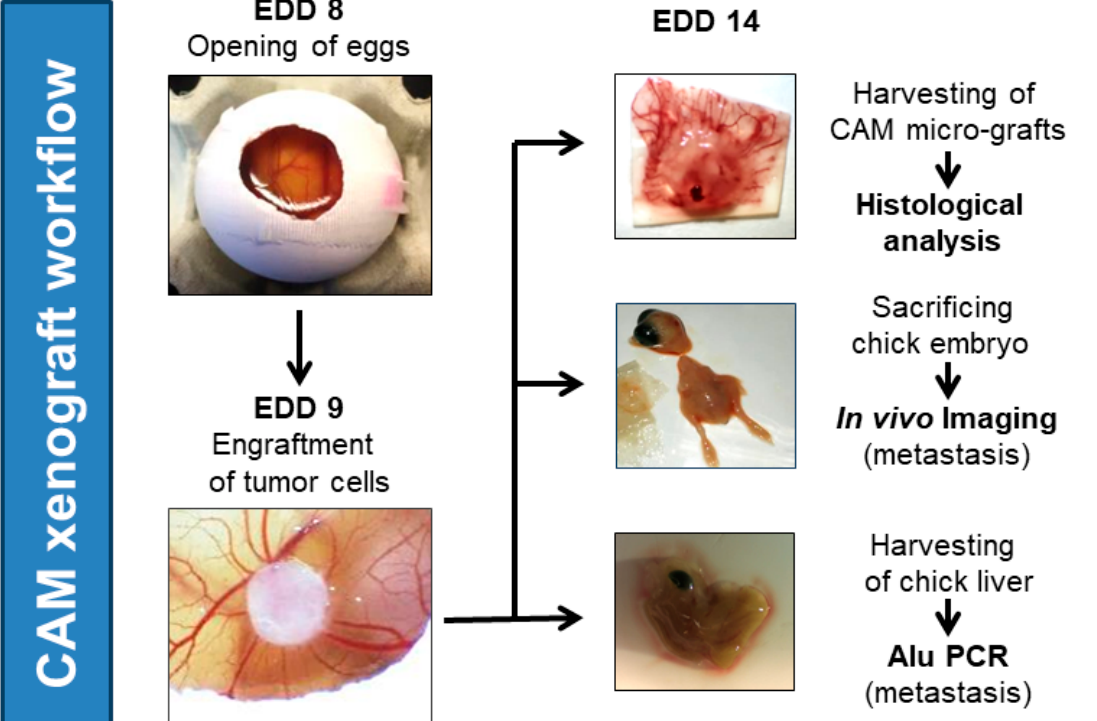
Figure 1. General workflow of in vivo CAM ovograft experiments. Eggs were opened on embryonic development day (EDD) 8. On the next day (EDD 9), tumor cell/Matrigel pellets (1 × 10 6 tumor cells per pellet; optionally, fluorescence-labeled tumor cells for in vivo imaging) were applied to the CAM. Then, ovografts were allowed to develop and grow for 5 days on the CAM. On EDD 14, CAM ovografts were harvested, embryos were sacrificed by decapitation, and chicken embryo livers were collected for further processing. The downstream investigations included the histological analysis of CAM ovografts, in vivo imaging to identify fluorescently labeled tumor cells in chicken embryos (dissemination), and human-specific Alu qPCR analysis to detect the DNA of human tumor cells in chicken livers (dissemination).